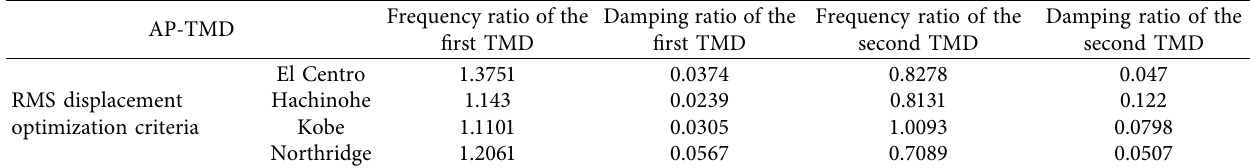
Table 9: The frequency and damping ratio of AP-TMD with maximum and RMS displacement optimization